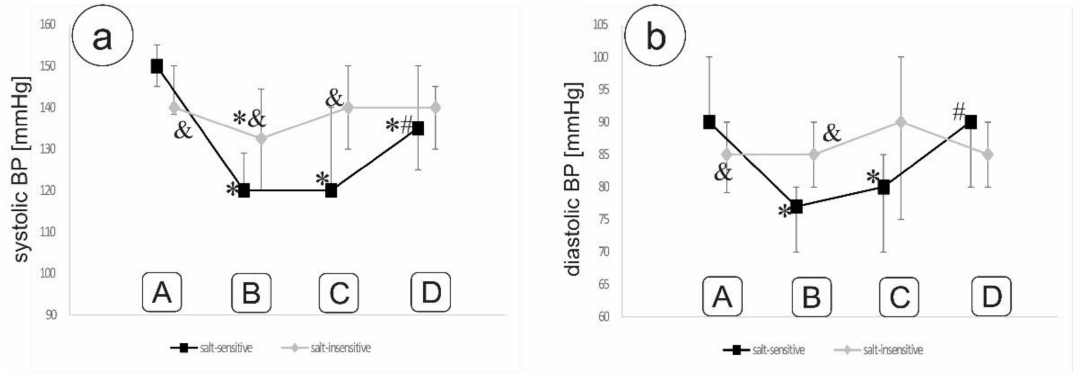
Figure 1. Systolic ( a ) and diastolic ( b ) office blood pressure throughout the study. * p < 0,05 vs. stage A; # p < 0,05 vs. stage C; and & p < 0.05 between groups. Description of stages A–D of the study is shown in Figure